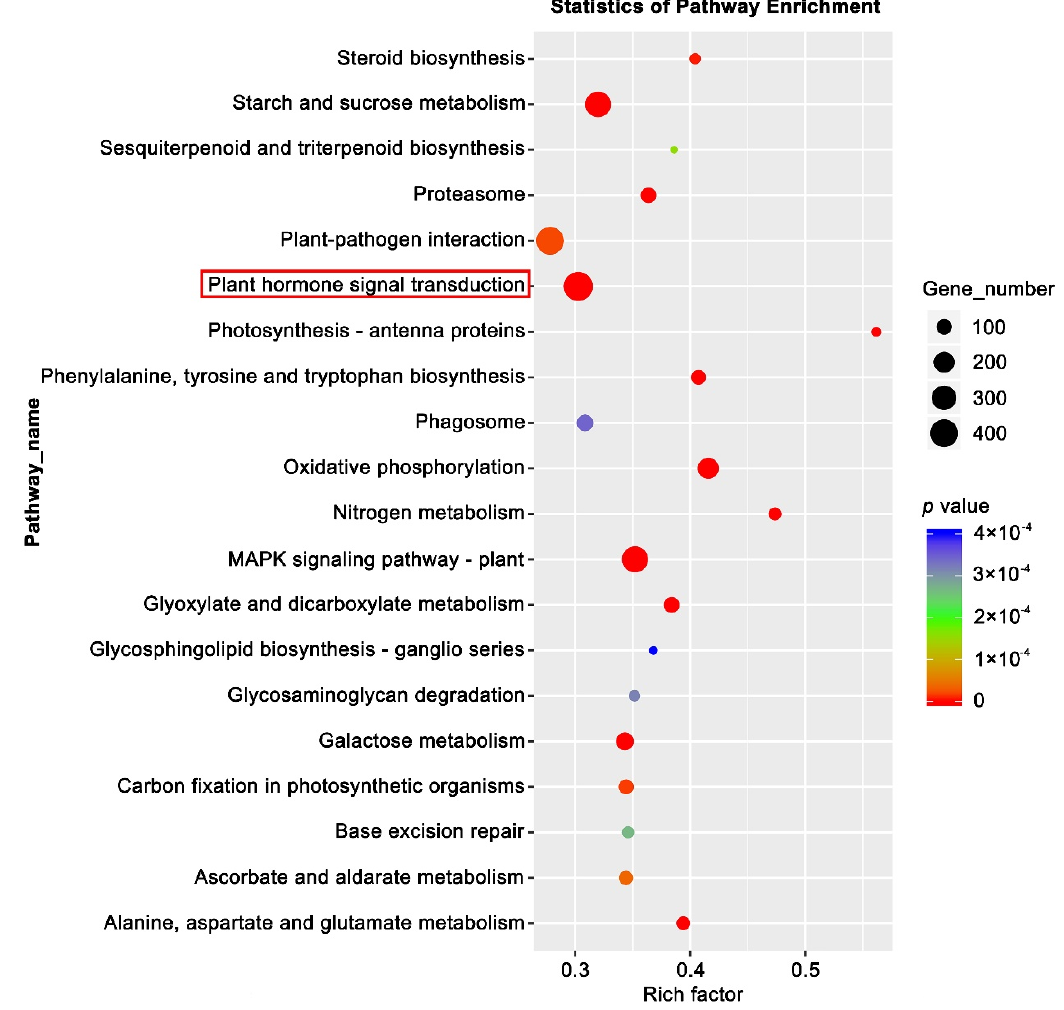
Figure 6. Kyoto Encyclopedia of Genes analysis of DEGs. KEGG pathway analysis of the DEGs showing the top 20 enriched pathways. The most enriched pathway—Plant hormone signal transduction is indicated by the red box.